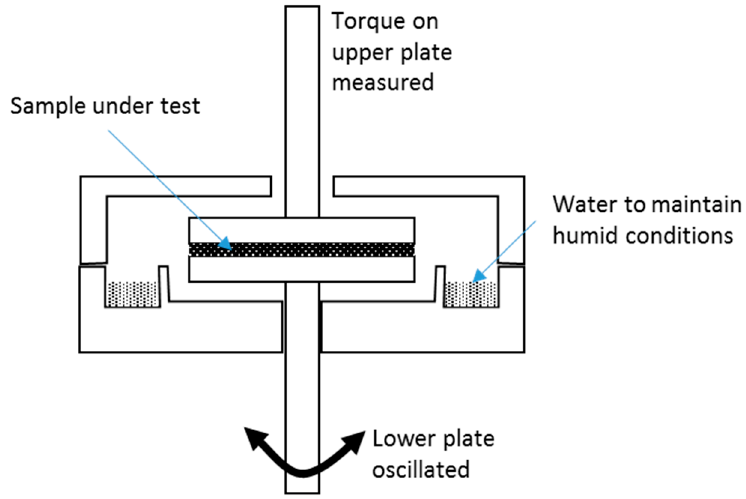
Figure 1. Parallel plates in a rheometer. A chamber can be constructed to maintain humidity and prevent desiccation of samples.